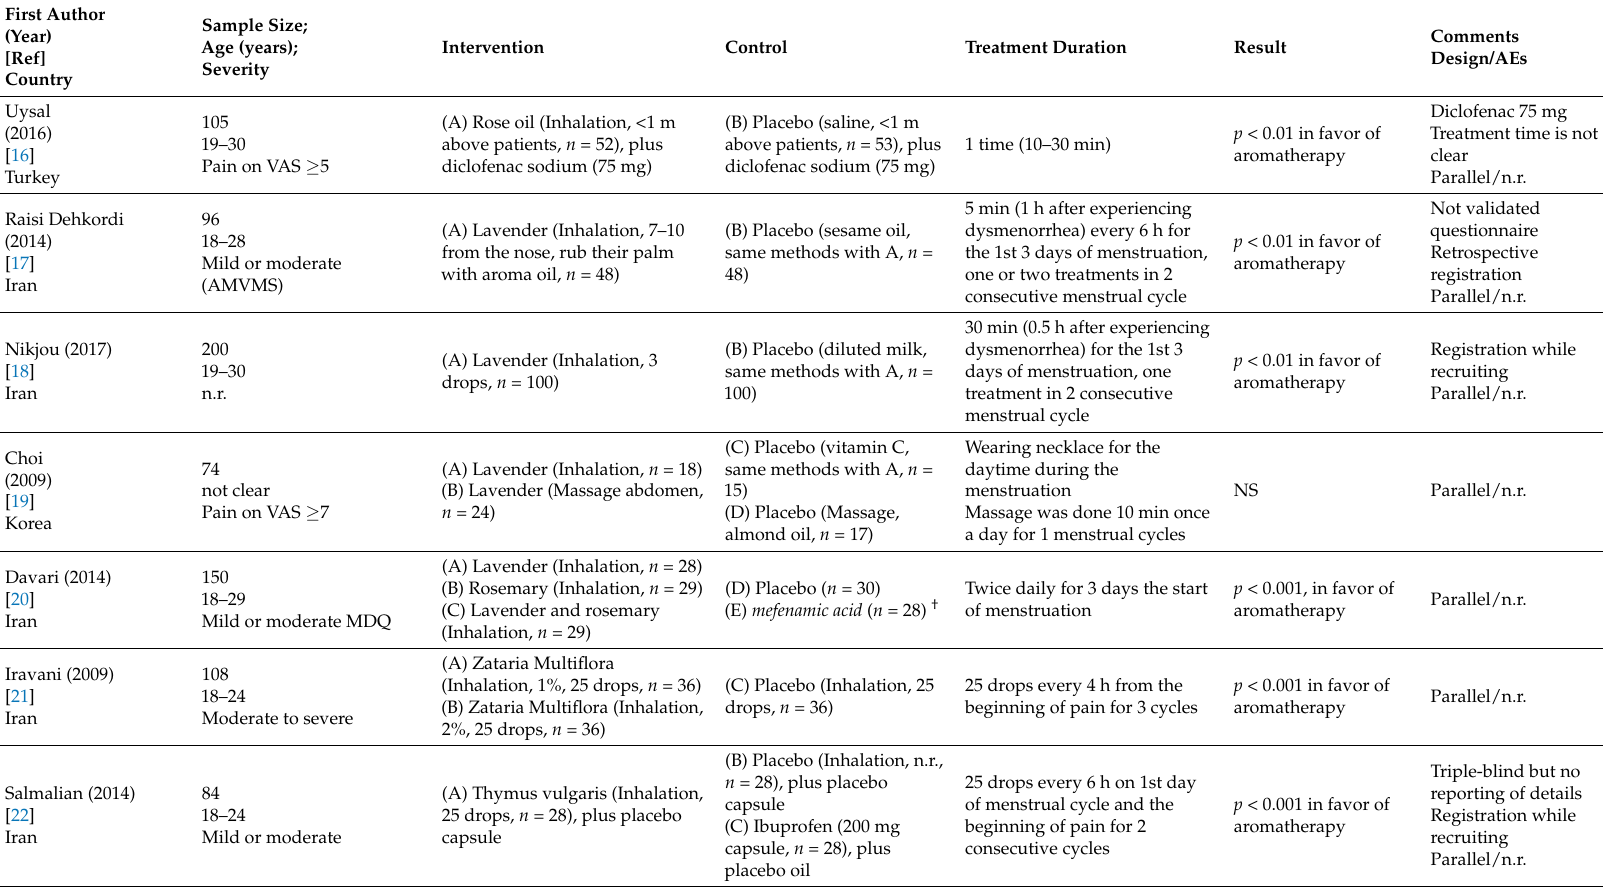
Table 1. Summary of randomized placebo-controlled trials of aromatherapy for dysmenorrhea